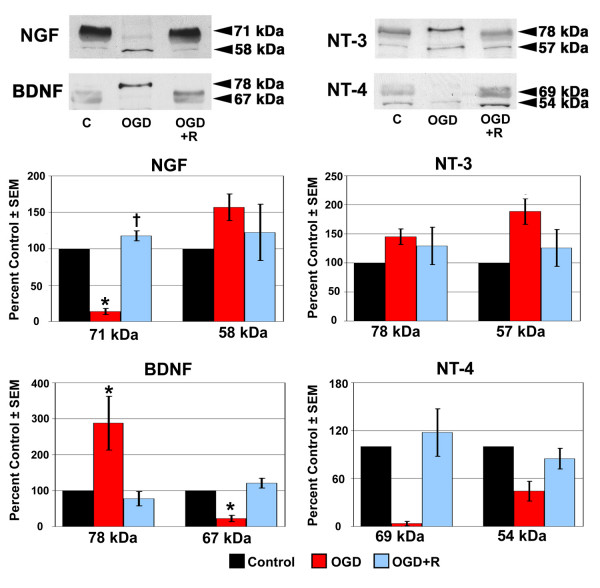
NT protein expression in ONH astrocytes following exposure to and recovery from Oxygen-Glucose Deprivation. ONH astrocytes were exposed to OGD for 48 hours (OGD) or to 48 hours OGD followed by recovery for 24 hours (OGD+R). Cells exposed to growth media and 95% air/5% CO2 for 48 hours served as controls (C). Cell lysate was separated by SDS-PAGE and the density of unsaturated bands was measured for each blot. A representative blot for each NT is shown. Band density reported as mean percent of the control ± SEM (n = 3) is shown graphically beneath the blots. * indicates p < 0.016 for OGD compared to C and OGD+R; † indicates p < 0.016 for OGD+R compared to C (one way analysis of variance [ANOVA] followed by validation using Student-Newman-Keuls tests).